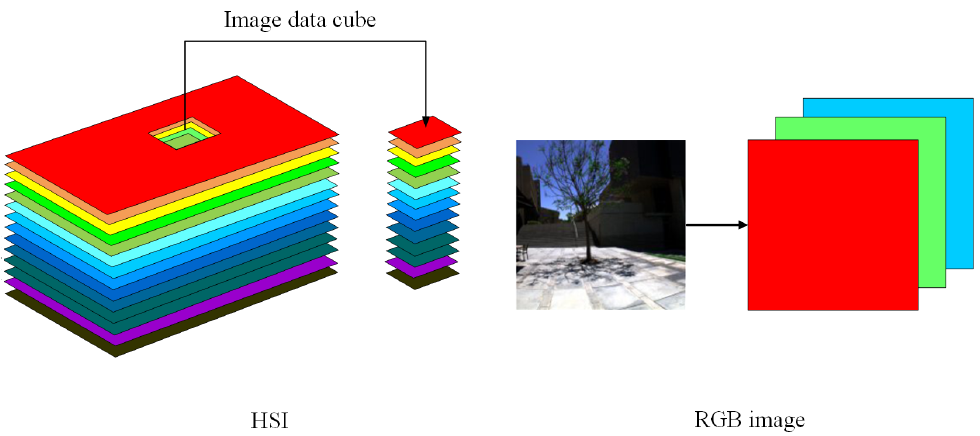
Figure 4. The difference in structure between HSIs and RGB